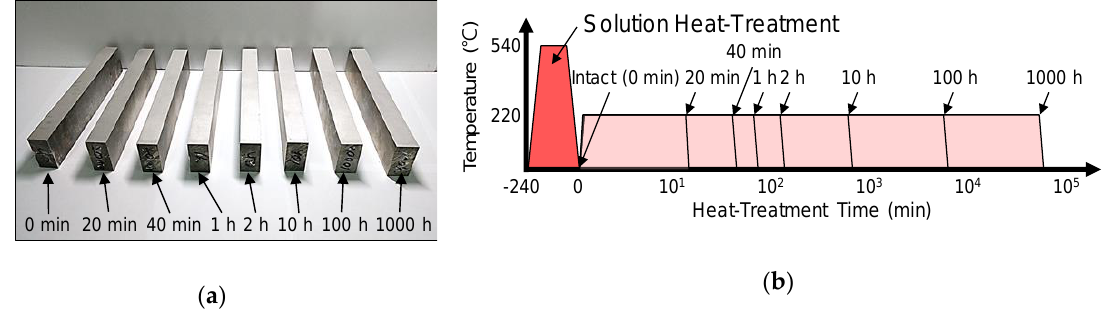
Figure 1. The aluminum specimens heat-treated for 0 min, 20 min, 40 min, 1 h, 2 h, 10 h, 100 h, 1000 h: ( a ) the picture of the specimens; ( b ) the gradual heat-treatment process for each specimen.